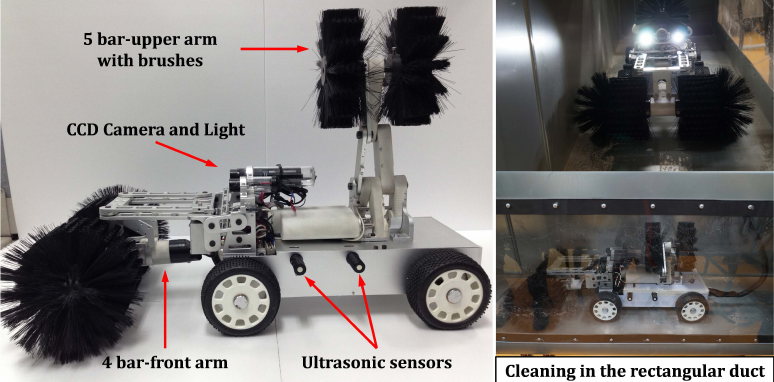
Figure 1. Duct cleaning mobile